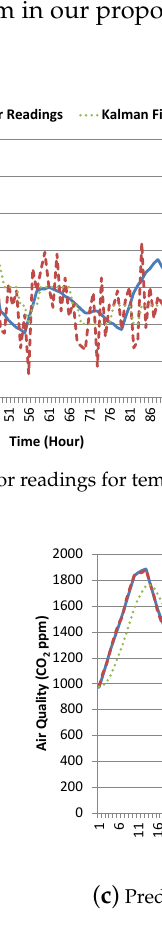
( c ) Predicted vs. sensor readings for air quality. Figure 6. Kalman filter predictions vs. sensor readings: first five days (120 h) of